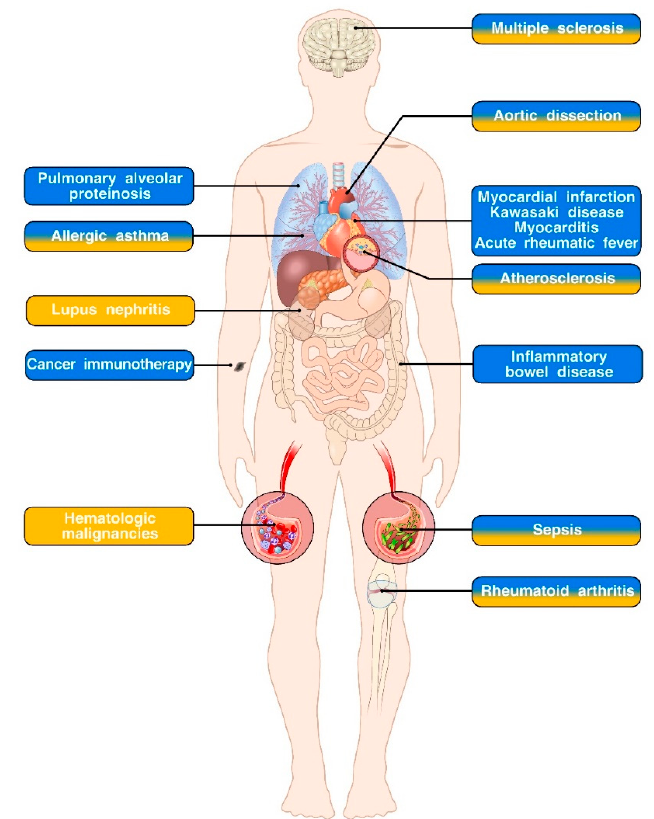
Figure 1. GM-CSF and IL-3 in immune-mediated diseases. Diseases in which a role for GM-CSF, IL-3 or both has been described are respectively indicated in blue, yellow or mixed blue/yellow boxes. Pre-